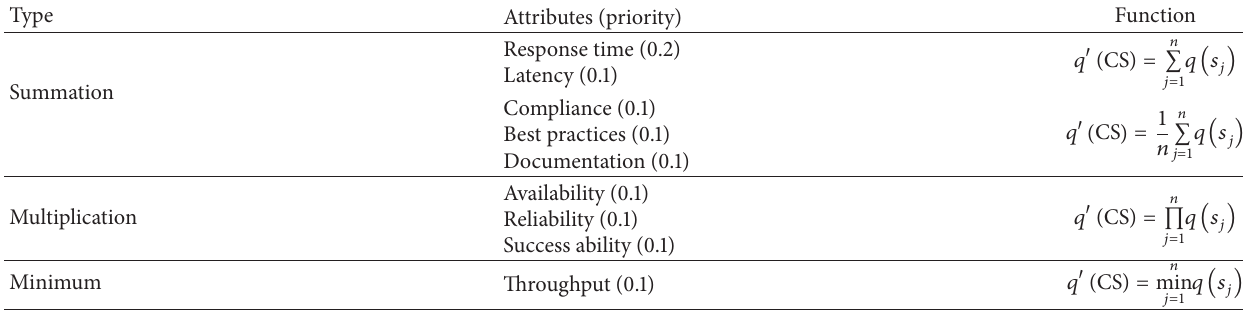
Table 1: The considered attributes, their priorities, and aggregation